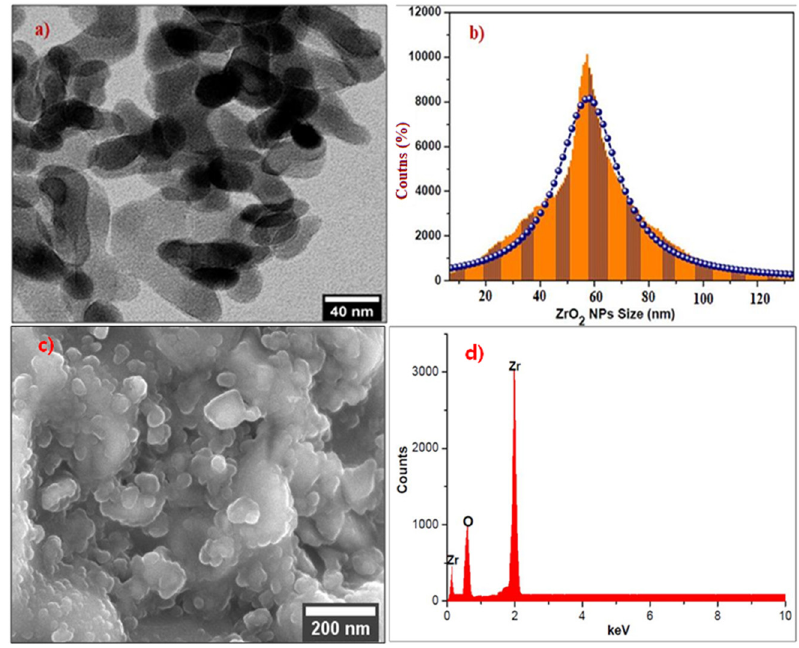
Figure 3. ( a ) TEM, ( b ) distribution histogram, ( c ) SEM, ( d ) EDX of nano-ZrO 2